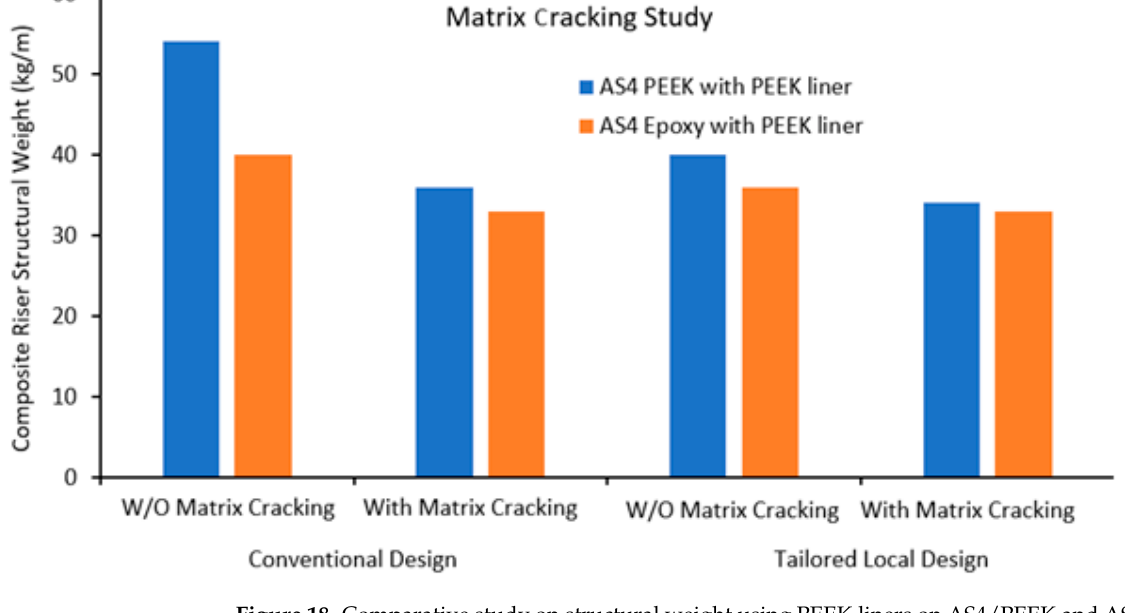
Figure 18. Comparative study on structural weight using PEEK liners on AS4/PEEK and AS4/Epoxy designed with matrix cracking and without matrix cracking permissions. designed with matrix cracking and without matrix cracking